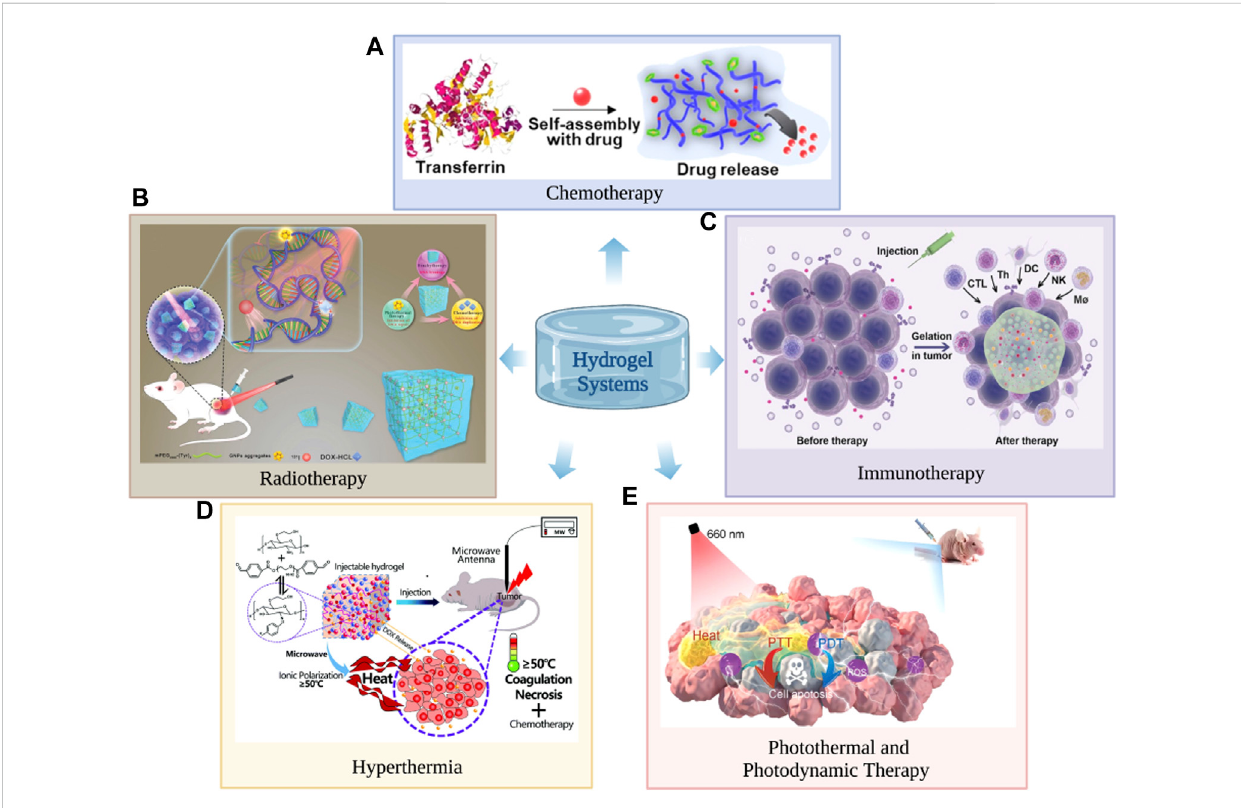
FIGURE 1 Hydrogels can be used in cancer chemotherapy (A) , radiotherapy (B) , immunotherapy (C) , hyperthermia (D) , photodynamic therapy and photothermal therapy (E) . (A) Reproduced with permission (Lee et al., 2021). Copyright 2021, John Wiley and sons. (B) The hydrogel consists of gold nanoparticle aggregates (GNPs), doxorubicin and radiationuclide iodine-131 (131I) labelled methoxy polyethylene glycol (mPEG), for which it is used in cancer radiotherapy. Reproduced with permission (Zhang et al., 2021a). Copyright 2021, John Wiley and sons. (C) Reproduced with permission (Li et al., 2021). Copyright 2021, John Wiley and sons. (D) Reproduced with permission (Wang et al., 2017). Copyright 2021, John Wiley and sons. (E) Reproduced with permission (Chen et al., 2021c). Copyright 2021, John Wiley and